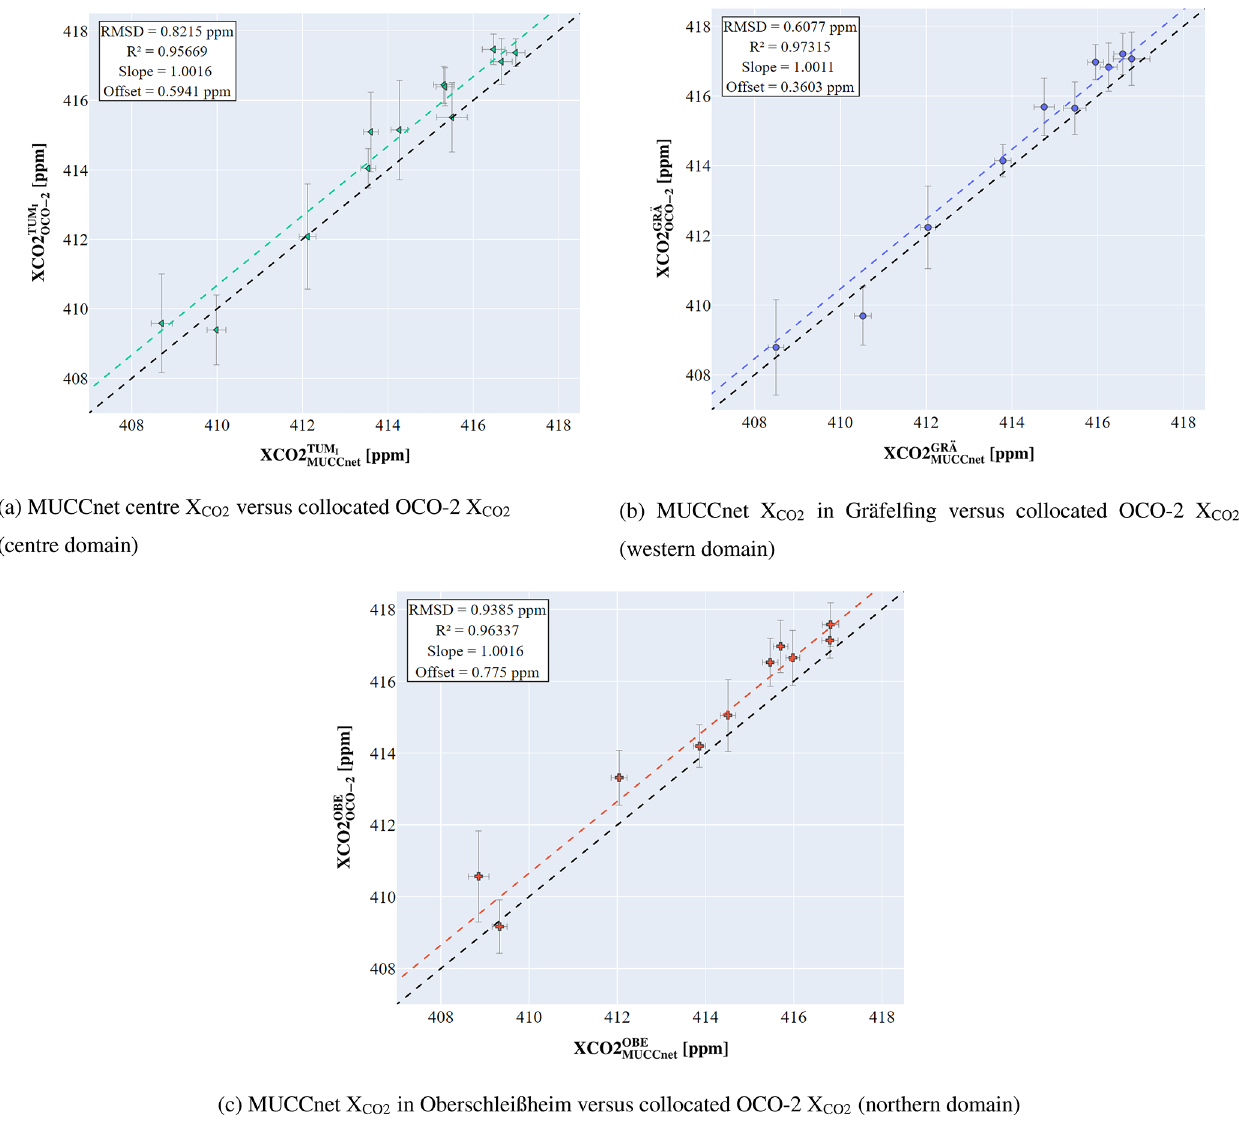
Figure 9. By-site comparison results for the three comparison domains in the center (TUM), west (GRÄ), and north (OBE) of Munich. We use the same color coding as in Fig. 5. OCO-2 has the largest bias and RMSD in the northern domain when compared to the collocated MUCCnet X CO . The error bars represent the standard deviations of the samples in the corresponding domain. 2